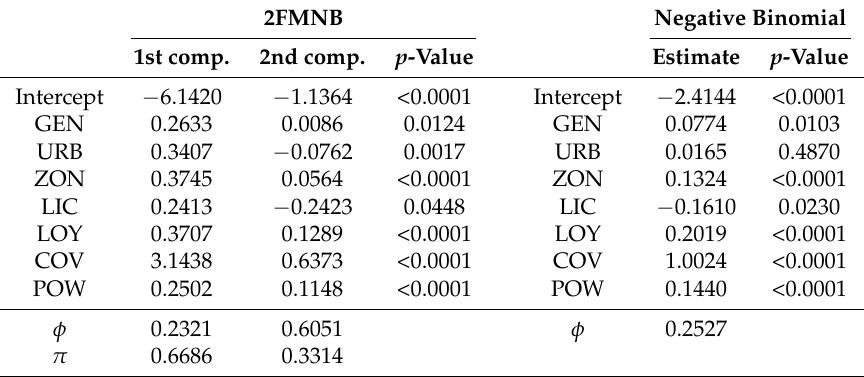
Table 3. The fitted models for both the negative binomial and the 2FMNB. The p -value for the 2FMNB refers to that of LRT when the variables is removed from both components, whereas for the simple negative binomial it refers to the Wald test. 2FMNB Negative Binomial 1st comp. 2nd